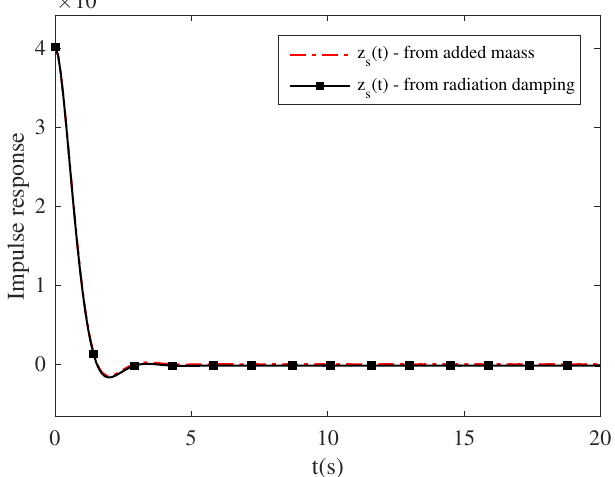
Figure 5. Impulse response of added inertia and radiation